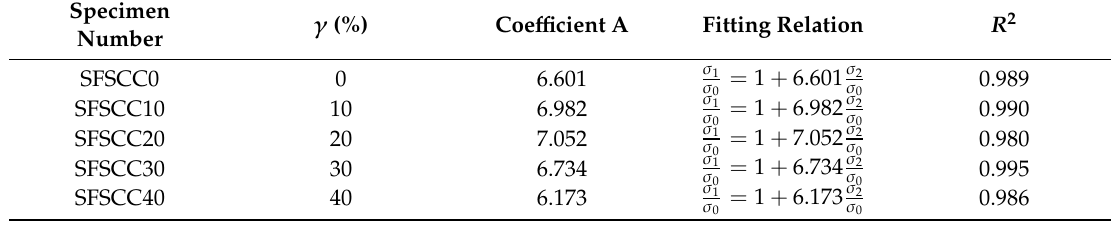
Table 8. Fitting relationship of SCC.